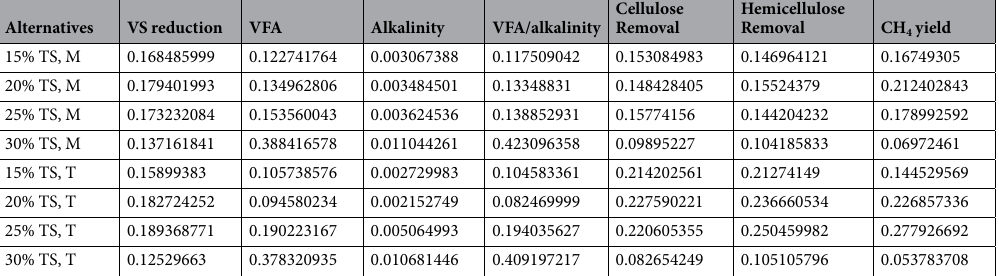
Table 6. Normalized matrix for each alternatives and criterion for VIKOR.